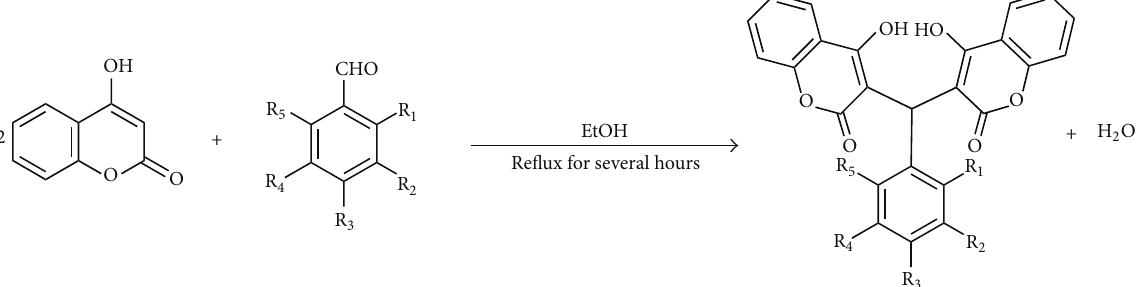
Figure 1: Synthesis of dicoumarol derivatives via condensation of 4-hydroxycoumarin with ortho -, meta -, and para -substituted benzaldehy-